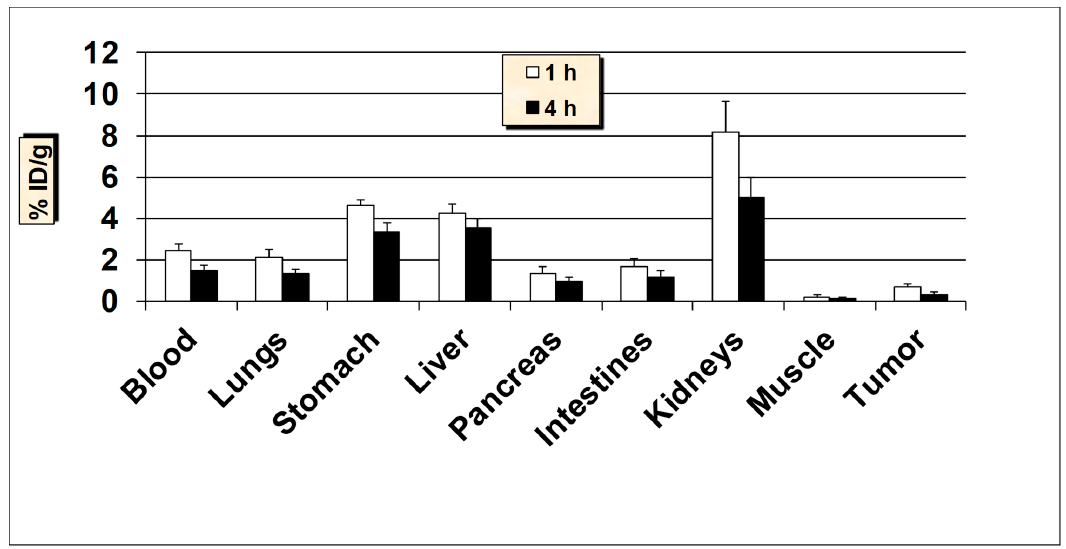
Figure 9. In vivo tumor-targeting properties of 99m Tc-HER2 peptide in HER2-negative MDA-MB-231 breast cancer xenografts mice models. Data is represented as % injected dose per gram (% ID/g) of tissue/organ (n = 3 − 5, mean values ± SD). Part of the intestines was measured without their contents .